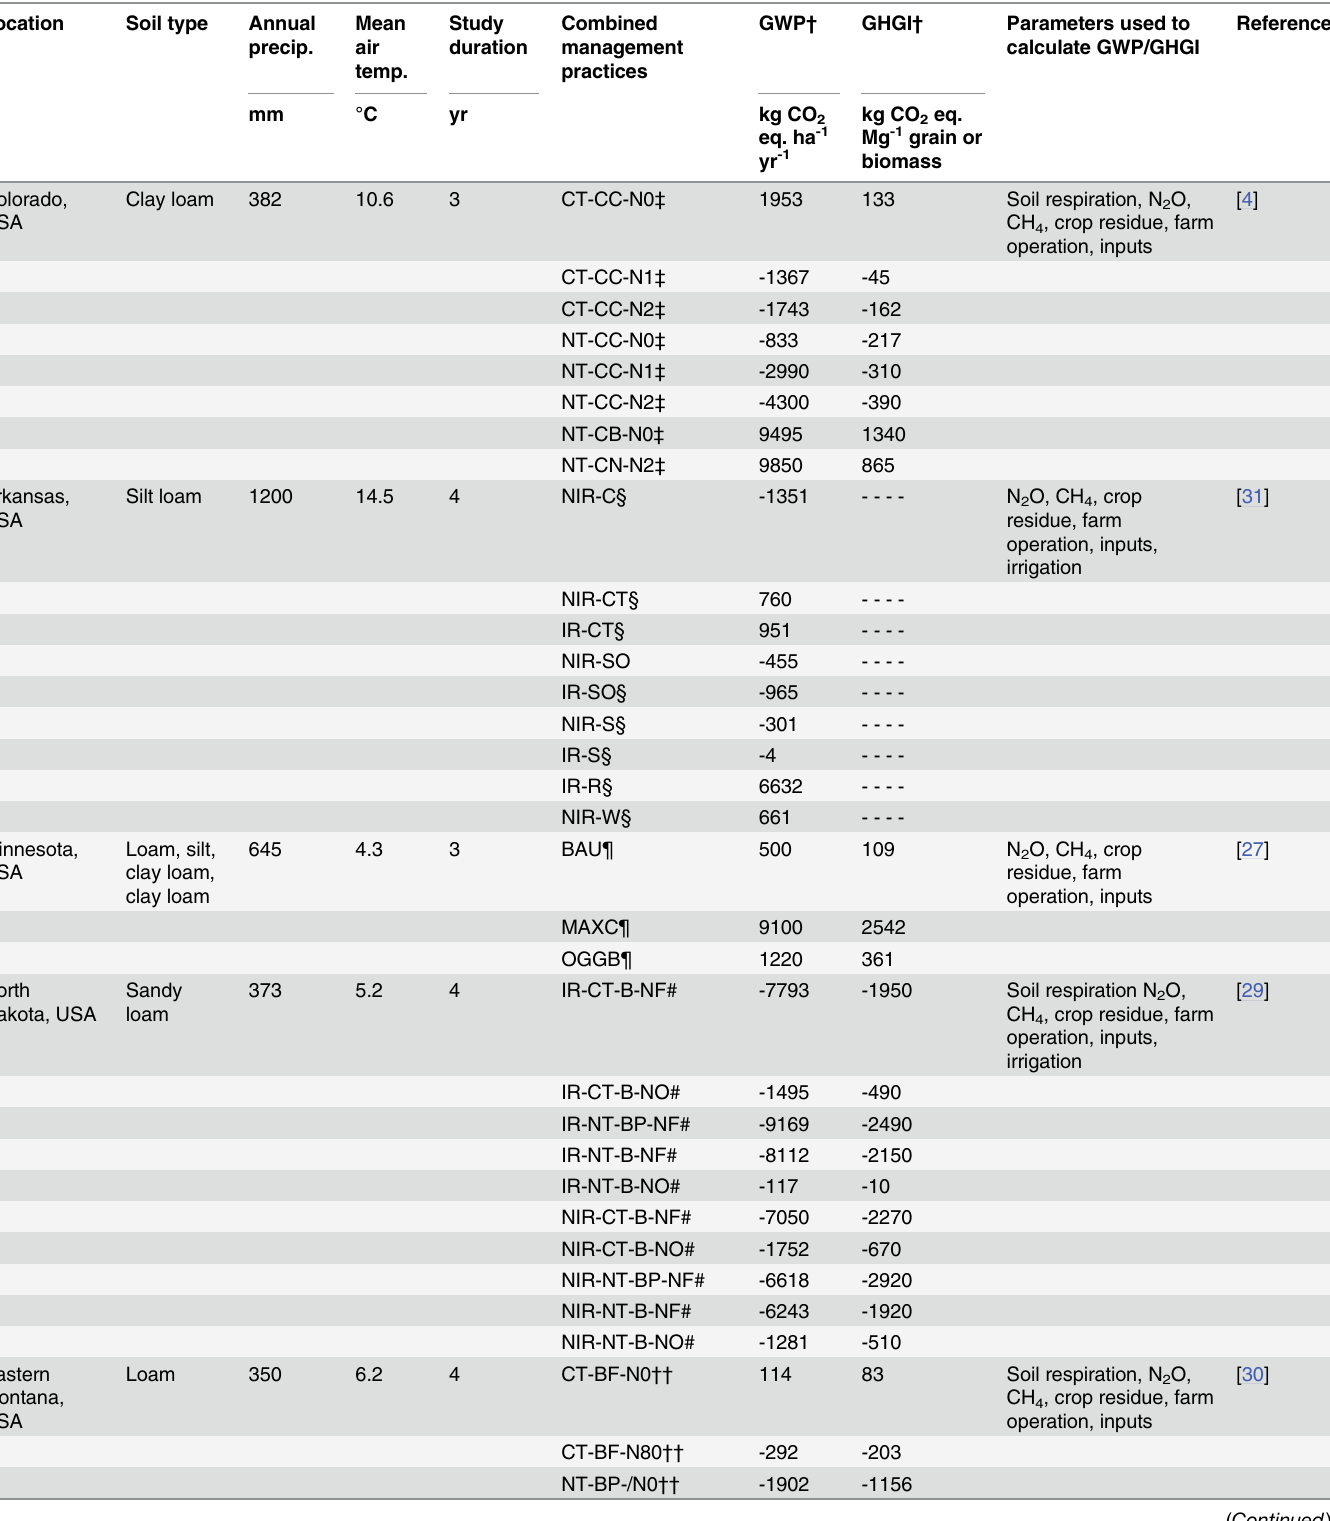
Table 5. Soil respiration method of calculating net global warming potential (GWP) and greenhouse gas intensity (GHGI) in various regions with different soil and climatic conditions as affected by combined management practices (tillage, cropping system, and N fertilization).